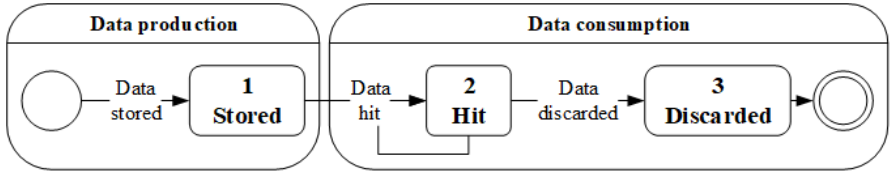
Figure 6. A state diagram of the data life cycle on the